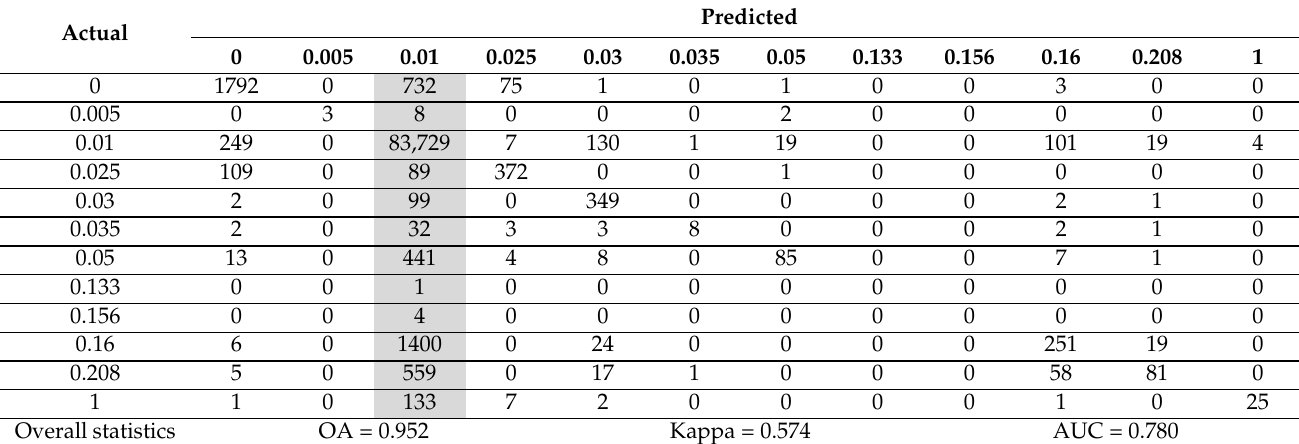
Table 7. The confusion matrix of the test data (4% sampling rate of the majority